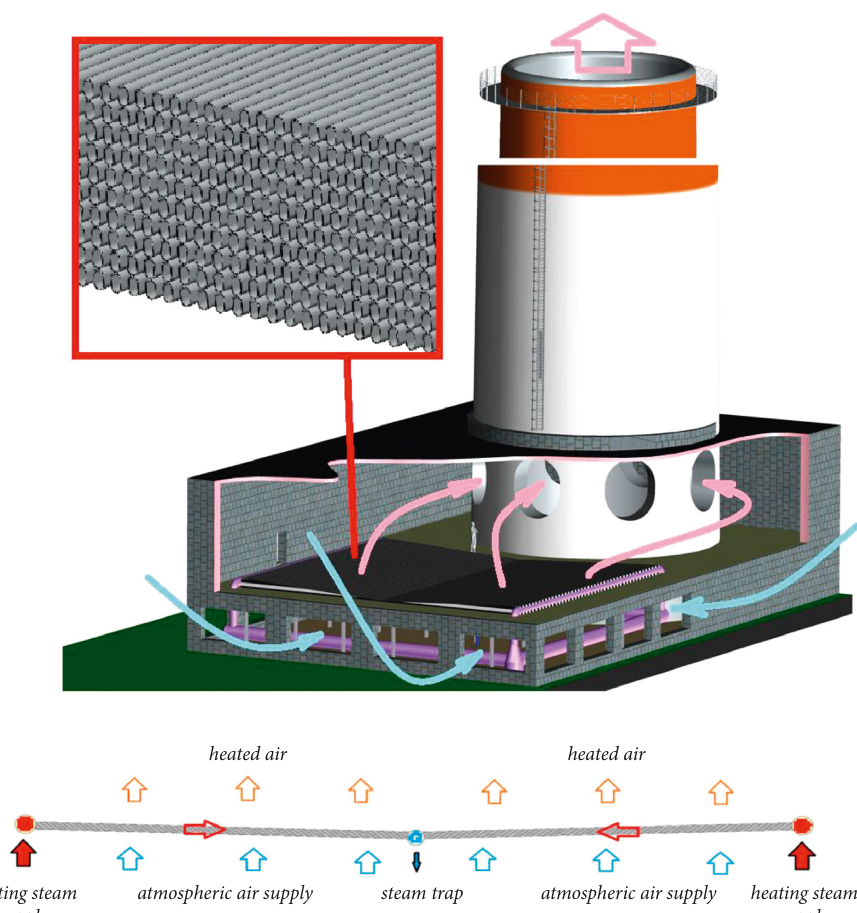
Figure 7: Scheme of heat transfer to the final heat sink, a fragment of a section of the air heat exchanger tube (top), and a scheme of coolant circulation in the air heat exchanger (bottom).